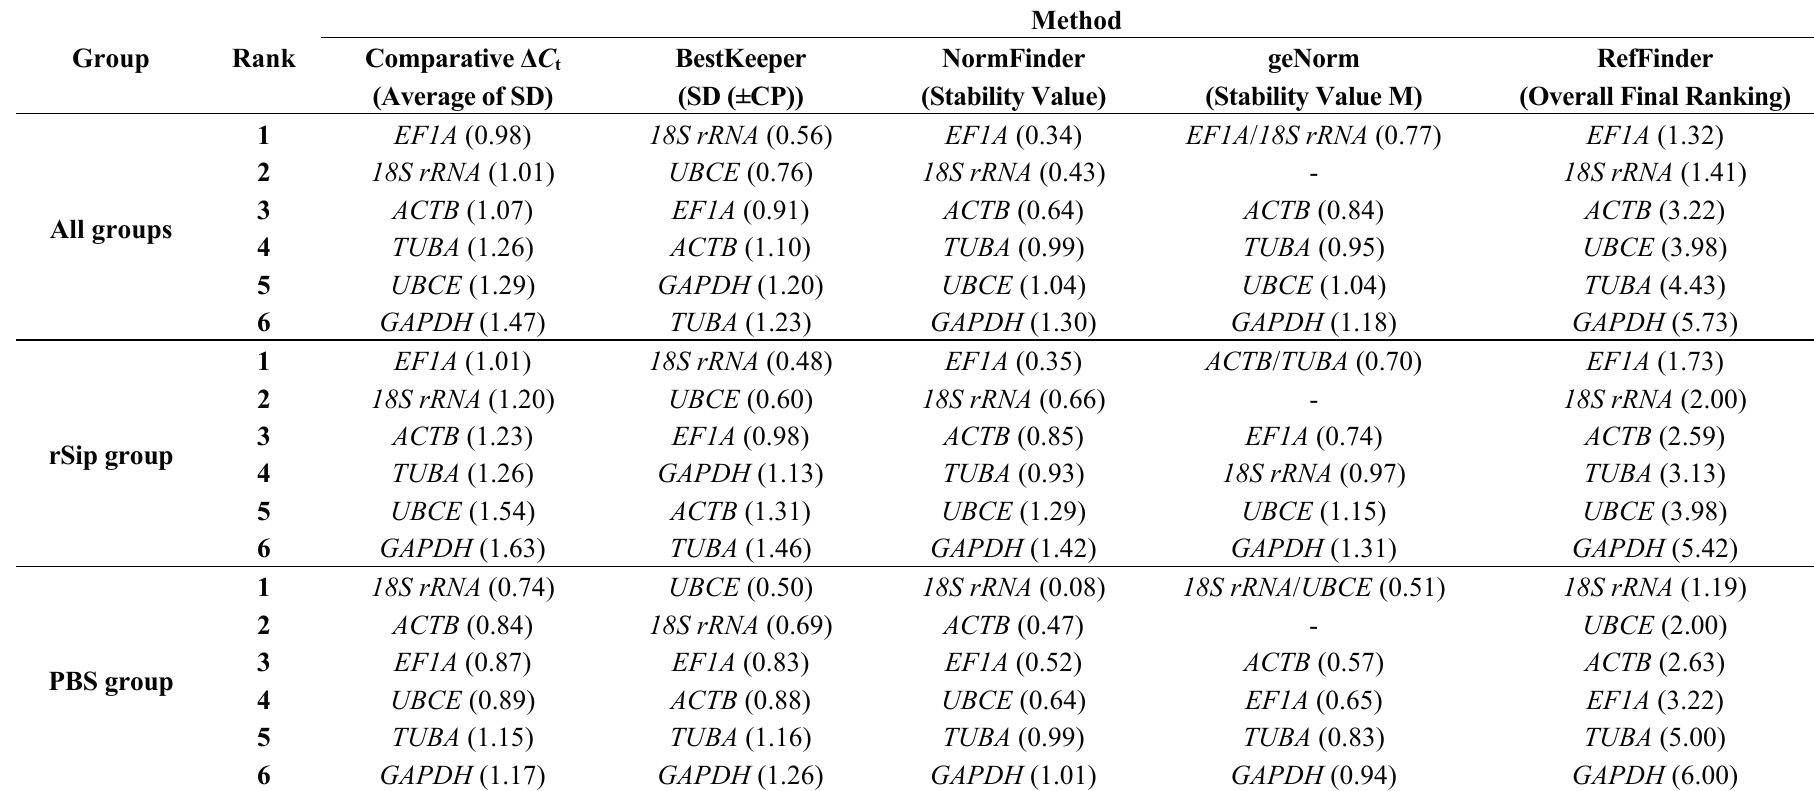
Table 3. Expression stability ranking of six candidate reference genes during vaccination and infection in spleen of different experimental